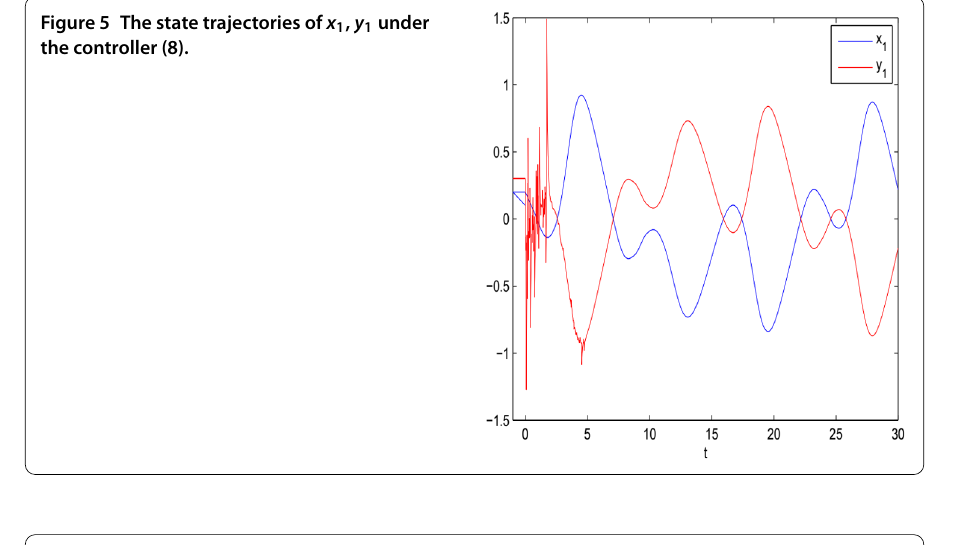
Figure 6 The state trajectories of x 2 , y 2 under the controller